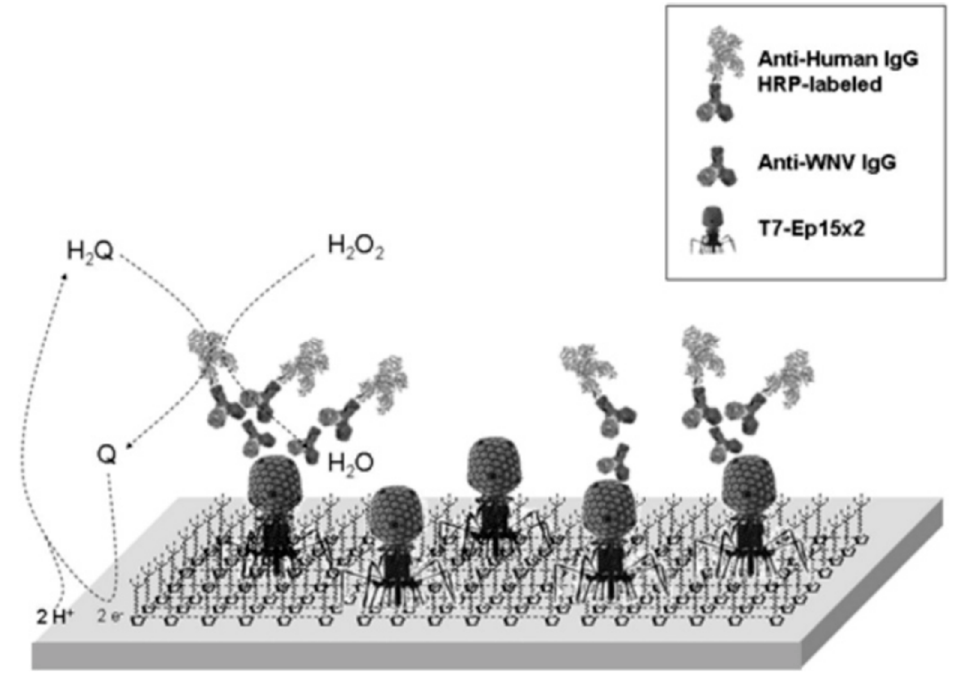
Figure 15. Scheme of T7 bacteriophage-based sensor for anti-WNV antibodies detection. WNV-epitope-carrying T7 phages are immobilized in the layer of conducting polymer. If the specific antibodies are present in the sample, they are bounded in a sandwich complex between a phage and a secondary antibody conjugated with an enzyme whose product is amperometrically detected [121]. Reprinted with permission from [121]. Copyright 2007 American Chemical Society.